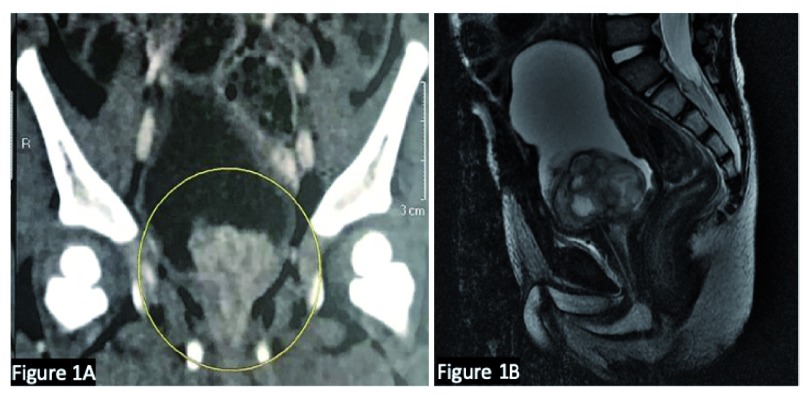
Computed tomography and magnetic resonance images of tumor.(
A) Computed tomography depicting bladder tumor at the trigone. (
B) Magnetic resonance image showing better characterization of location and extent of the tumor. We confirm that the patients gave us permission to use these images.